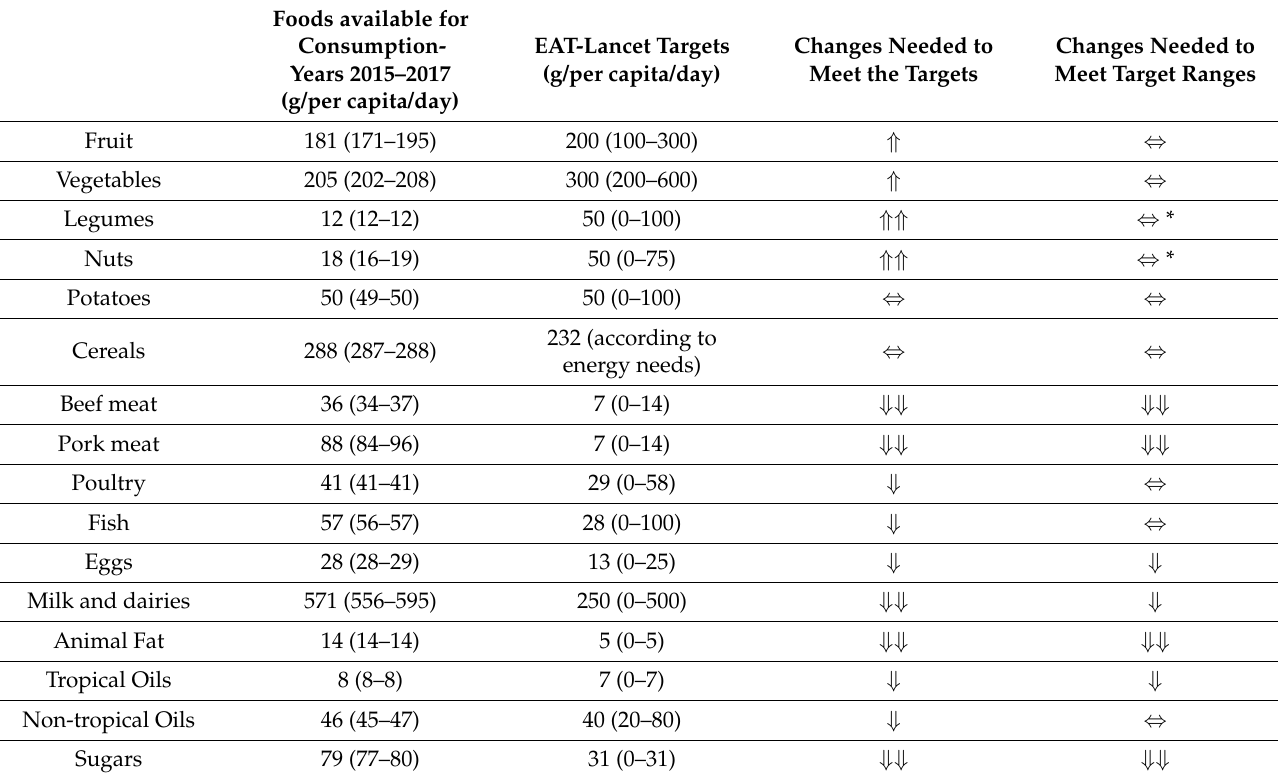
Table 3. Amounts of foods available for consumption (average and ranges) in Italy at the last available observation (years 2015–2017) compared to the targets and ranges proposed by the EAT–Lancet